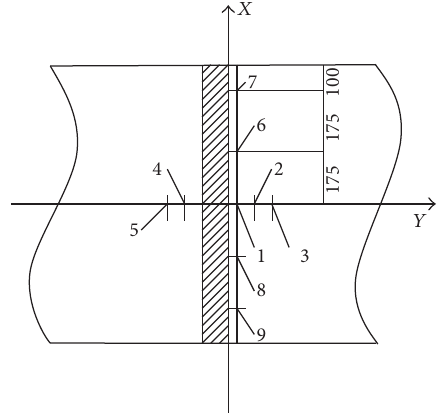
Figure 4: Arrangement of the testing points.